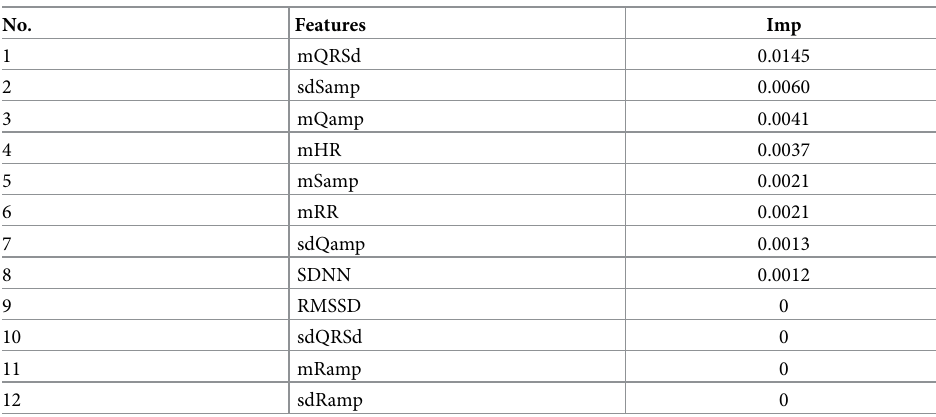
Table 2. Estimates of Imp for 12 features.